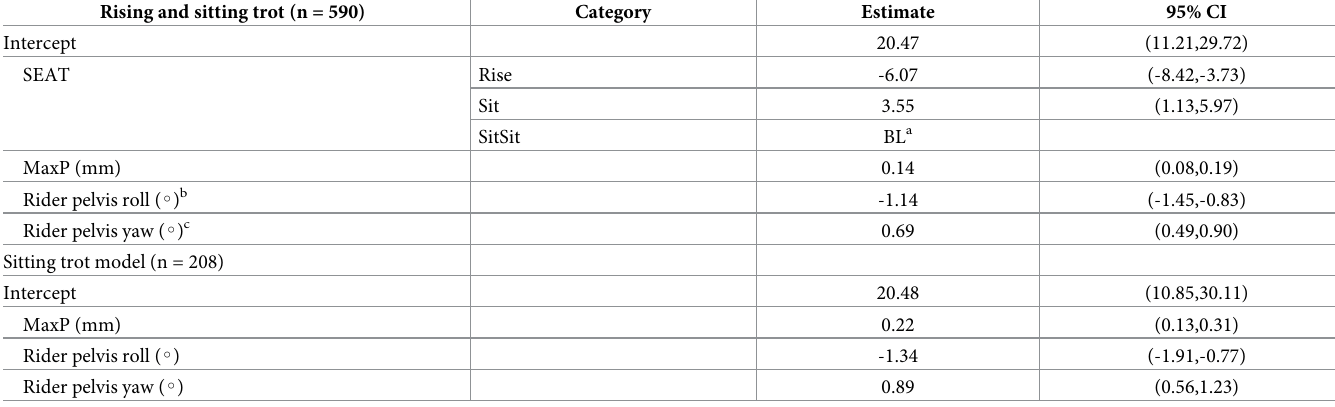
b Rider pelvis roll; positive for rotation away from the supporting hindlimb side c Rider pelvis yaw; positive for rotation away from the supporting hindlimb